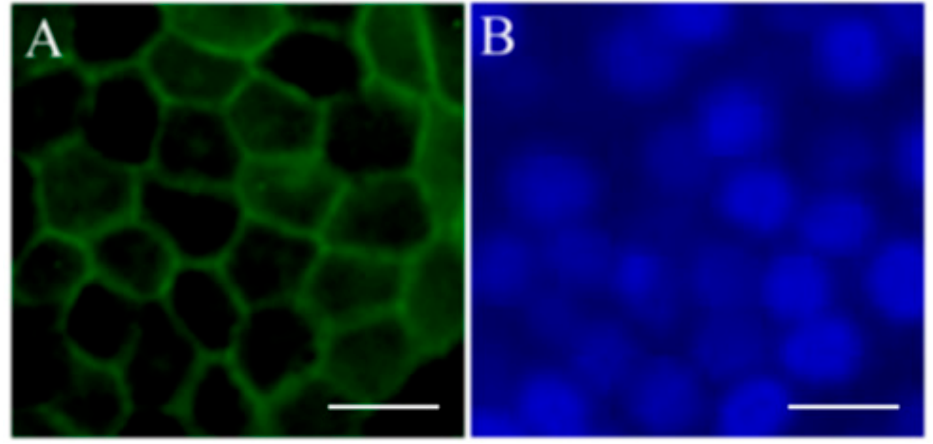
Figure 2. Expression of retinal pigment epithelium (RPE) cell markers in induced pluripotent stem cells (iPSC)-derived RPE. Immunofluorescent staining of RPE marker ZO-1 ( A ) in pigmented iPSC-derived RPE cells; ( B ) DAPI image of same cells. Scale bars = 50 μ m. With the full permission of all authors of the original publication, Figure 4 of [76] has been included here.